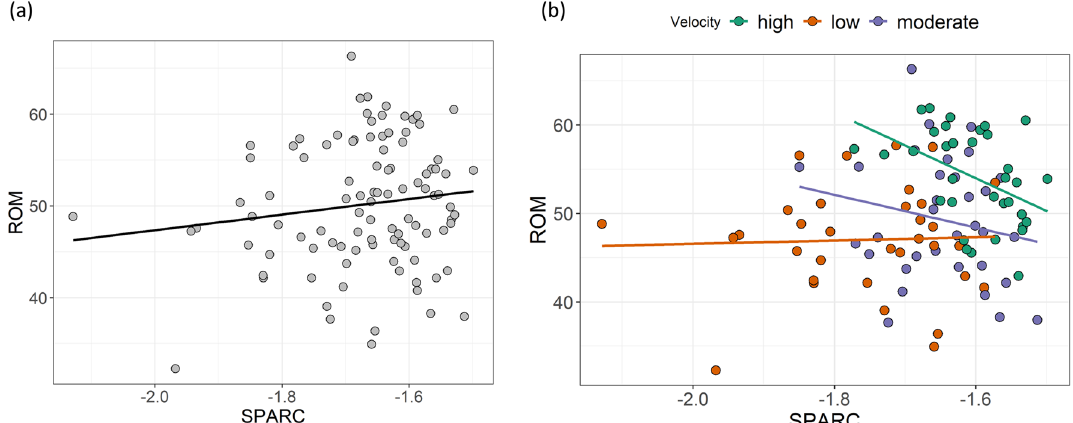
Figure 4. Association between ROM and SPARC before ( a ) and after ( b ) conditioning on velocity. ROM Range of motion (degrees), SPARC Spectral arc length (smoothness of neck